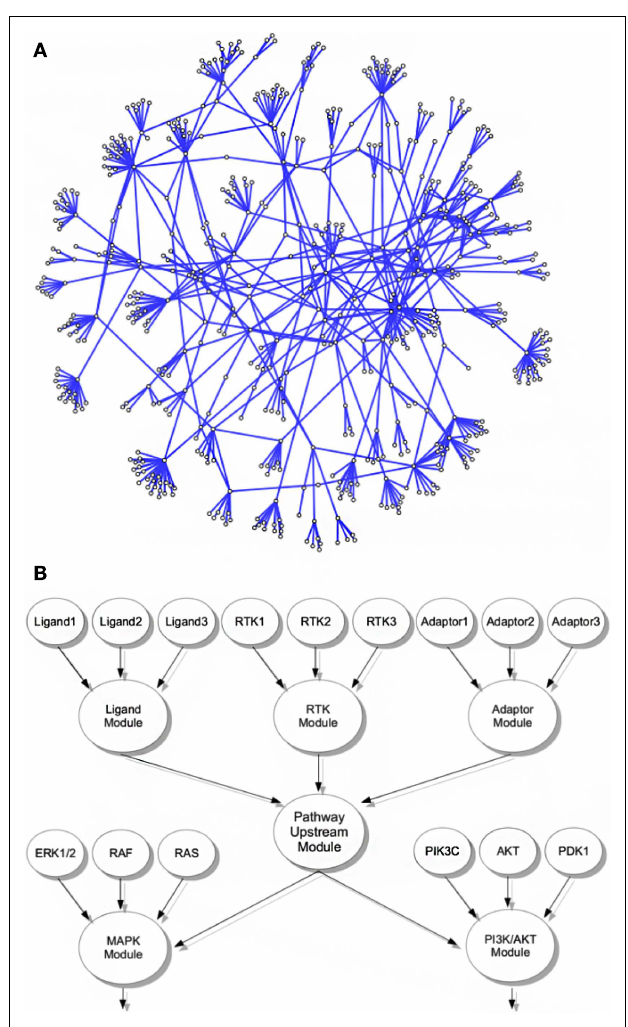
FIGURE 1 | Interconnected signaling network of cancer-related genes and modules . (A) Representation of the cancer relevant signaling network including all modules and contributing genes. (B) Exemplified schematic layout of the module grouping strategy; all genes in the network were associated with functional modules, e.g., genes encoding ligands, RTKs, or adaptor proteins of a given pathway were grouped into the corresponding ligand, RTK, or adaptor modules. In living cells, these modules contribute to activity of the pathways upstream signaling, here represented by a pathway upstream module. Functionally, the pathway upstream module of a given pathway activates or inhibits the activity of distinct downstream modules, here exemplified for activation of a MAPK and a PI3K/AKT module.These modules themselves consist of associated genes, e.g., encoding for ERK, RAS, or RAF isoforms in case of MAPK signaling or PI3K catalytic and regulatory isoforms as well as AKT, PTEN, and others. In our network, these downstream modules are again linked to events acting further downstream in the pathway, like activation of an AP1 or MYC transcription factor